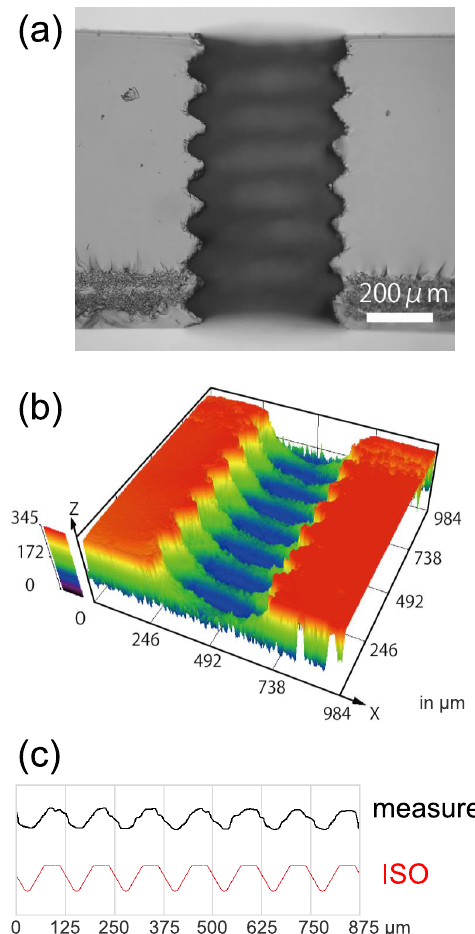
Figure 3. Internal surface of fabricated threaded hole after cleaving. ( a ) Optical microscopy image; ( b ) Laser-scanning microscopy image (oblique view), the unit is µ m; ( c ) Comparison of cross-sectional profile between fabricated thread and ISO1501. The vertical scale is the same as the horizontal scale.